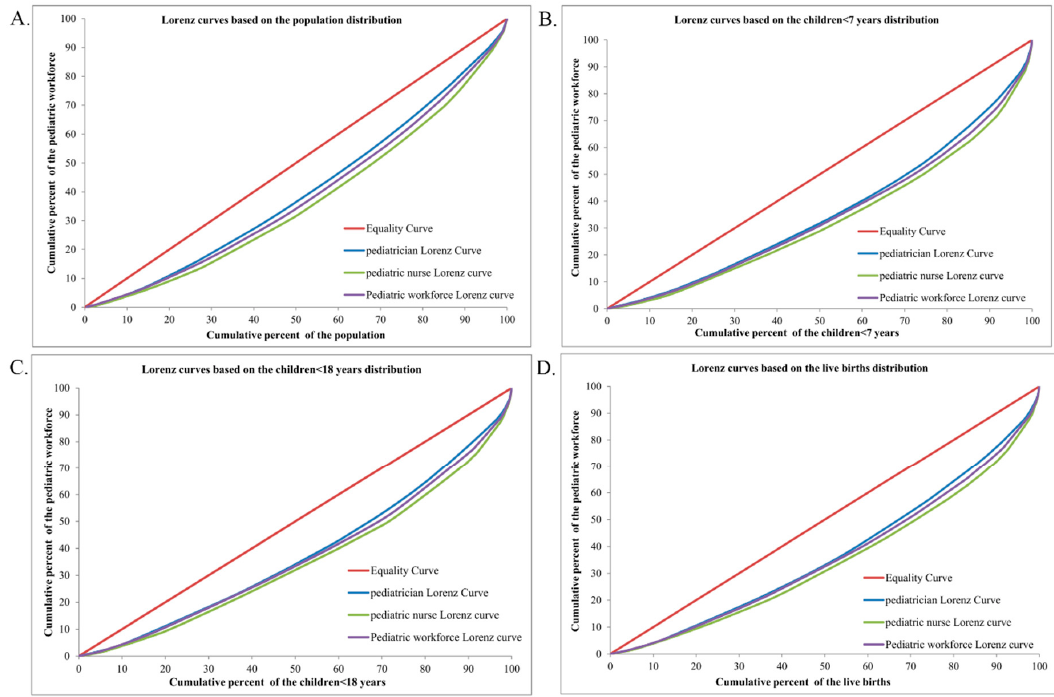
Figure 2. Lorenz curves for the demographic distributions of different indicators. ( A ) Based on the population distribution; ( B ) Based on the children <7 years distribution; ( C ) Based on the children <18 years distribution; ( D ) Based on the live births distribution.